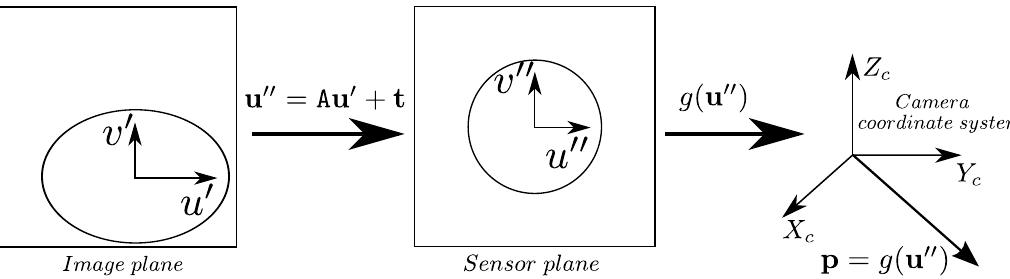
Figure 3: The back-projection of a point on image plane into 3D camera coordinate system. An image point is mapped onto the sensor plane via affine transformation. Given pre-calibrated image, the point on the sensor plane can be back-projected into the 3D camera coordinate system using the non-linear function g .